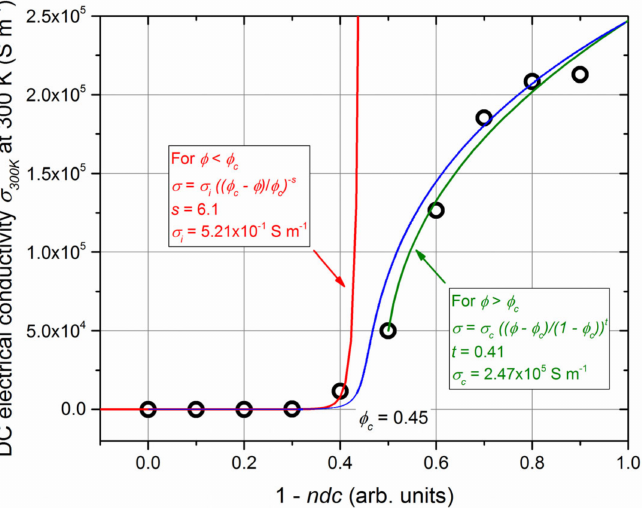
Figure 8. DC electrical conductivity at room temperature ( σ 300K ) vs. φ = 1- ndc for Ti-B-N thin films ( ndc is the normalized duty cycle). Red and green lines are related to the conductivity calculated from the fitting before (Equation (1)) and after (Equation (2)) the percolation threshold. The blue line is the best fit obtained from Equation